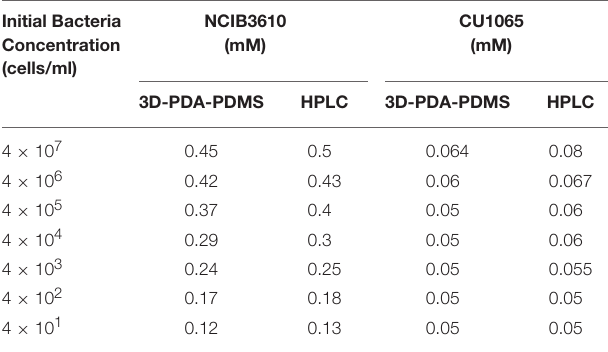
TABLE 1 | Quantification and comparison of surfactin levels measured by using the immobilized PDA lipid vesicles and HPLC method. Initial Bacteria